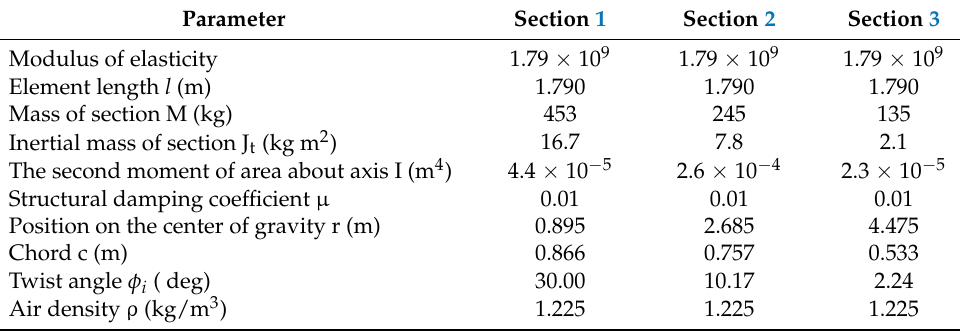
Table 1. Input parameters of the modeled blade (Abomsa site).